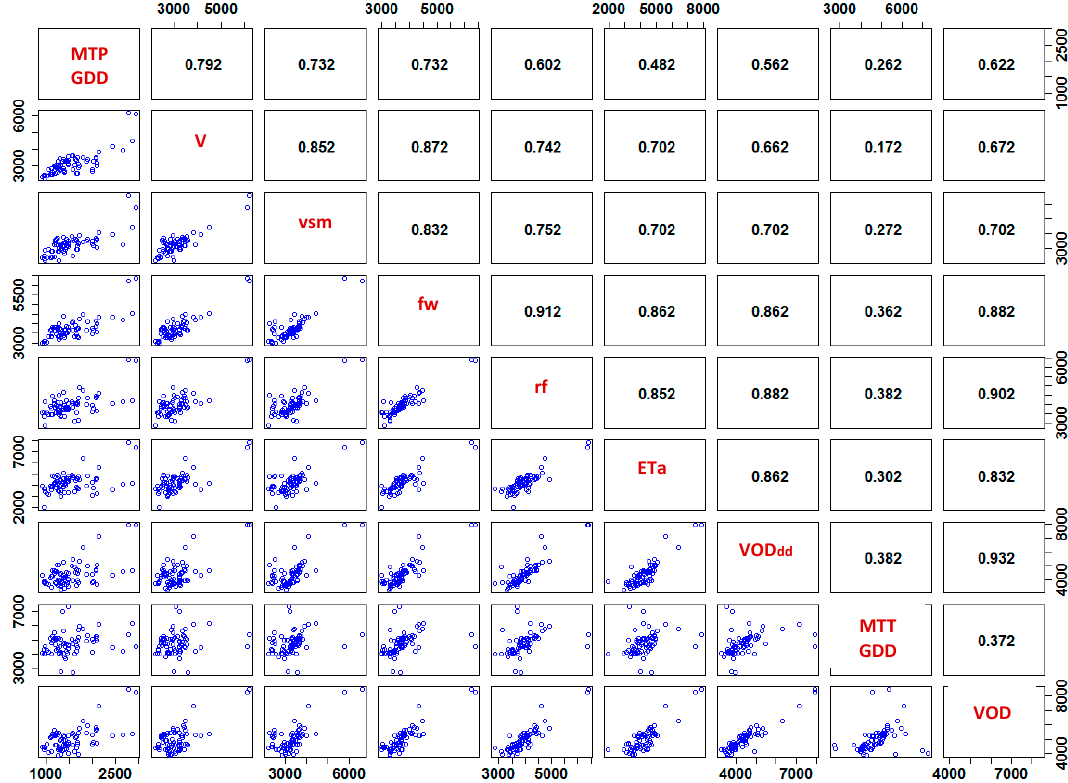
Figure 15. Moisture Time to Peak (MTP) or Moisture Time to Trough (MTT) for cropland land surface variables in Ethiopia for 2003–2015 (r 2 > 0.8). The variables listed in the diagonal of the figure from top-left to bottom-right include moisture time to peak or trough for MTP for growing degree-days (MTP GDD), precipitable water vapor (V), volumetric soil moisture (vsm), fractional open water (fw), rainfall (rf), actual evapotranspiration (ETa), vegetation optical depth diel difference (VODdd), MTT for growing degree-day (MTT GDD), and vegetation optical depth (VOD). Note that peak rf lags peak V, peak soil moisture, and peak VOD, but VODdd lags peak rf. Upper panel shows the Pearson correlation coefficients. All correlations were significant with p < 0.01. To identify variables combination for any given plot or r-value, make horizontal and vertical lines towards the diagonal line of the square matrix containing the variables.